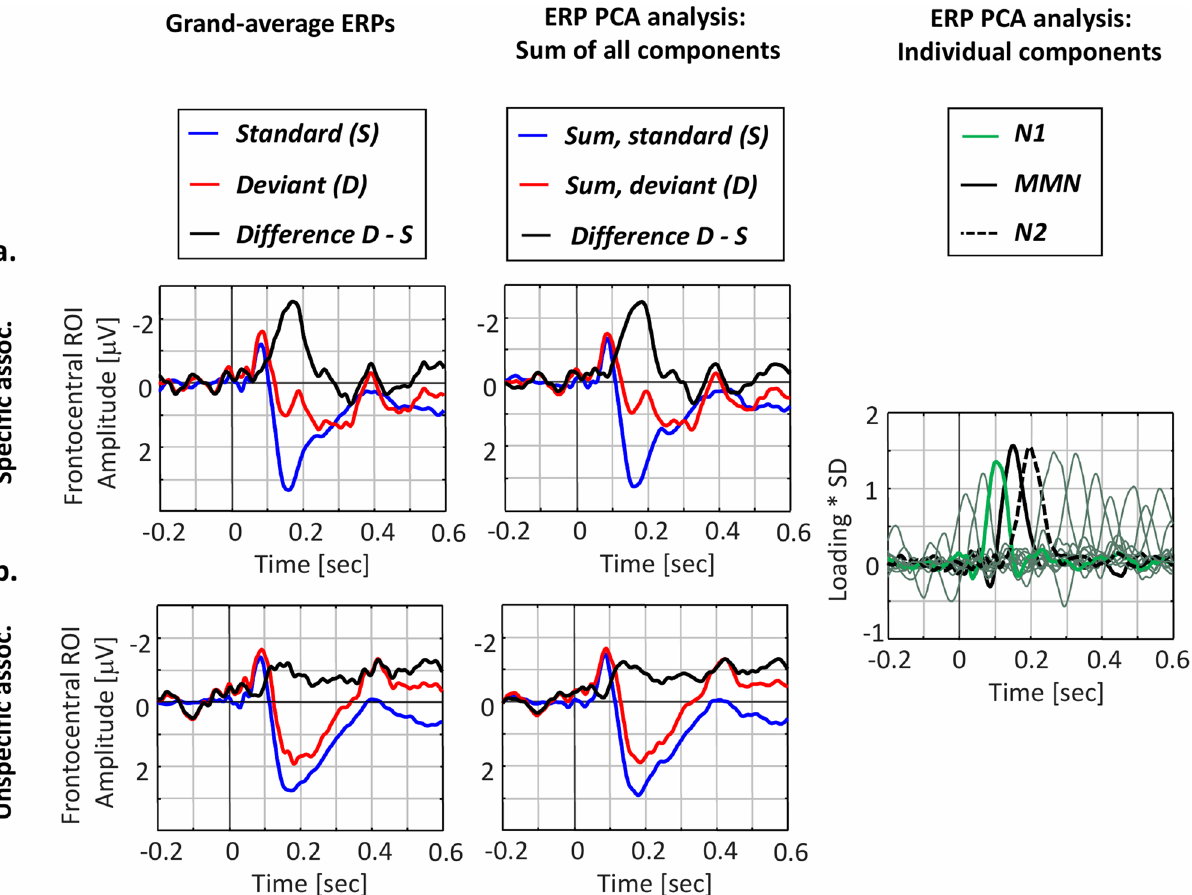
Figure 2. ERP PCA results. Grand-average ERPs (left) display the standard, deviant and difference waves for the conditions with specific ( a ) and unspecific ( b ) associations, for an average of frontocentral Fz, FC1, FC2, Cz, CP1, and CP2 electrodes. Following the PCA analysis, 14 principal components explaining more than 95% of the epoch variability were retained, the sum of these components or the so-called reconstruction waves (middle) being displayed again for the standard, deviant, and difference wave in both conditions, for the same average of electrodes as before. Note that the reconstruction waves correspond well to the grand-average ERPs indicating the PCA solution accurately represents the original data. The 14 retained components are presented individually (right); out of these, three components presumably representing N1, MMN, and N2 responses were further analysed. Figure generated in MATLAB, version R2017a (http:// www. mathw orks. MMN: The frequentist repeated-measures ANOVA brought forward a significant main effect of Stimulus type ( F (1, 13) = 19.79, p < 0.001, η 2 p = 0.604) and a significant interaction of Condition × Stimulus type ( F (1, 13) = 11.79, p = 0.004, η 2 p = 0.476), while the main effect of Condition was non-significant ( F (1, 13) = 1.2, p = 0.292, η 2 p = 0.085; see Table 1). The Bayesian t -tests corresponding to the main effect of Stimulus type brought strong evidence for the alternative hypothesis ( BF 10 = 56.27), as did the comparison regarding the interaction term ( BF 10 = 11.1), while the evidence corresponding to the main effect of Condition weakly supported the null hypothesis ( BF 10 = 0.45). Following up on the interaction term bringing evidence for the existence of MMN condition differences, the direct comparison of deviant vs. standard tones demonstrated significant elicitation of MMN in both the SPEC ( t (13) = 4.76, p < 0.001), as well as in UNSPEC conditions ( t (13) = 3.36, p = 0.005). Complementary Bayesian t -tests further proved that the alternative hypothesis was strongly supported in the SPEC ( BF 10 = 92.41), and moderately to strongly supported in the UNSPEC condition ( BF 10 = 9.98). To conclude, the data indicated that the MMN component was elicited in both conditions, but stronger in SPEC condition (see also Fig. 4b). N2: The frequentist repeated-measures ANOVA pointed to significant main effect of Condition ( F (1, 13) = 11.24, p = 0.005, η 2 p = 0.464) and Stimulus type ( F (1, 13) = 15.23, p = 0.002, η 2 p = 0.540), as well as to a signifi- cant interaction term ( F (1, 13) = 7.54, p = 0.017, η 2 p = 0.367; see Table 1). The Bayesian t -tests corresponding to the main effect of Stimulus type brought strong evidence for the alternative hypothesis ( BF 10 = 23.59), while the evi- dence corresponding to the main effect of Condition and interaction term moderately supported the alternative hypothesis in both cases ( BF 10 = 9.75 and BF 10 = 3.75, respectively). Following up on the interaction term bringing evidence for the existence of condition differences regarding the N2 effect, the direct comparison of deviant vs. standard tones demonstrated significant elicitation of N2 in the SPEC ( t (13) = 3.91, p = 0.002), but not in the UNSPEC ( t (13) = 1.83, p = 0.082) condition. This was confirmed by the Bayesian complementary comparisons